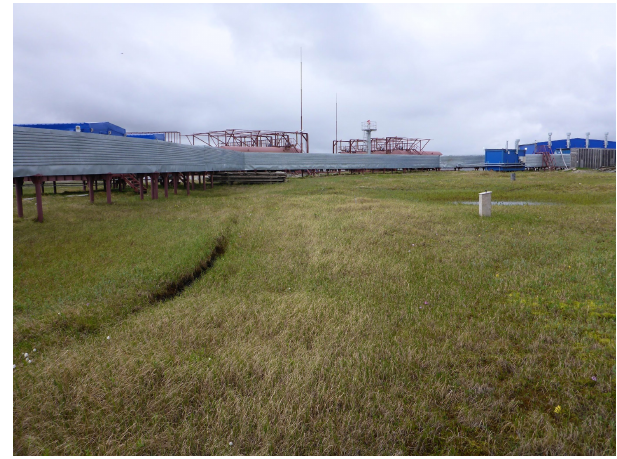
Figure E4. Borehole location (wooden box on right side) with the new Samoylov research station and water supply system (silver metal structure extending above the tundra